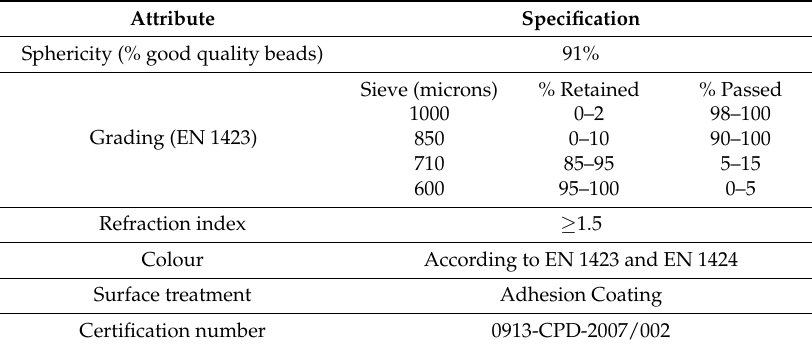
Table 8. Ultralux glass microbeads specifications.